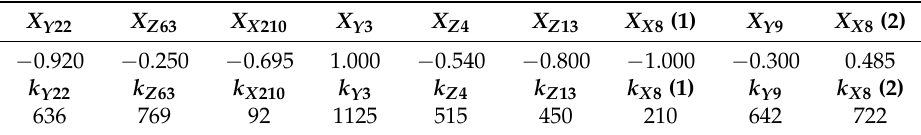
Table 13. Updated values of the design variables. Units of k i are N/ µ m.